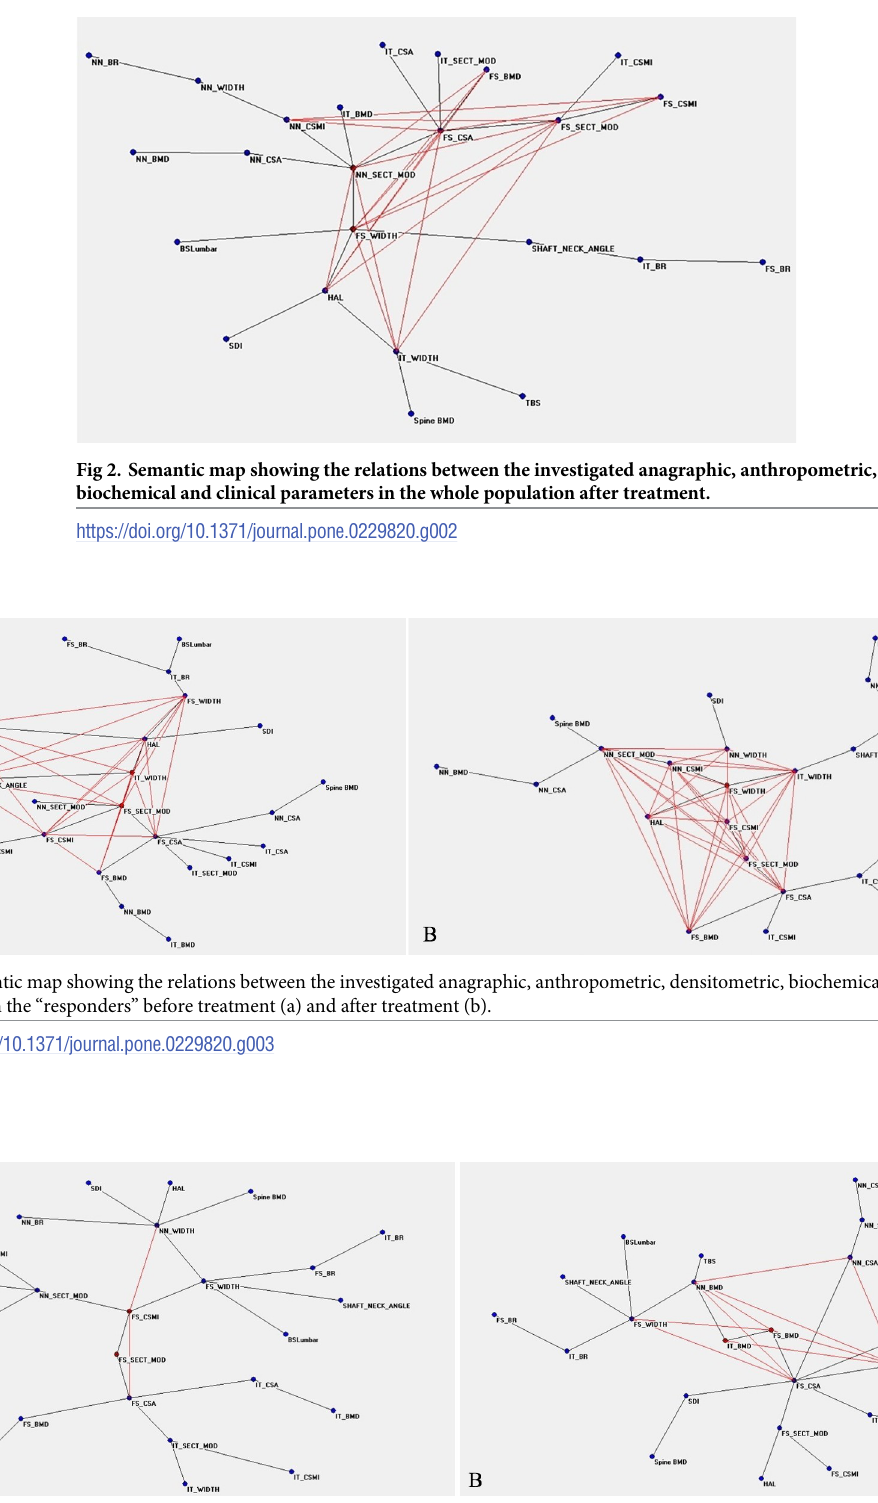
Fig 4. Semantic map showing the relations between the investigated anagraphic, anthropometric, densitometric, biochemical and clinical parameters in the “non-responders” before treatment (a) and after treatment (b).